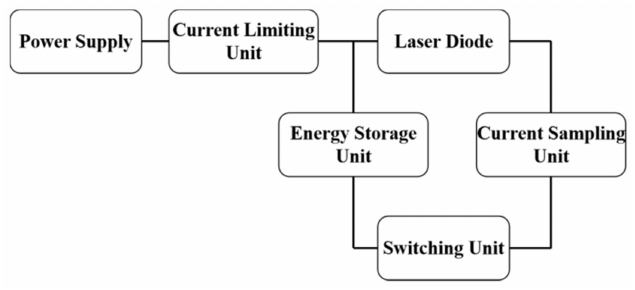
Figure 1. Laser drive circuit